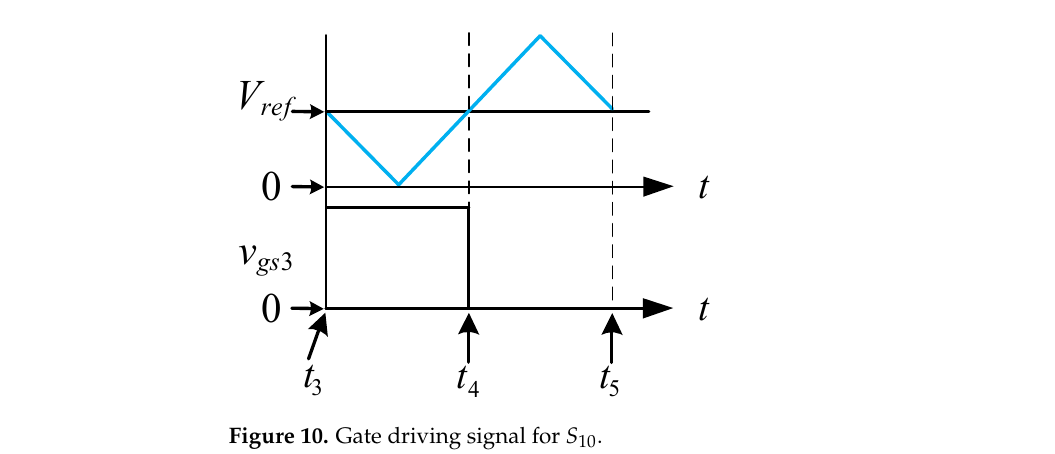
Figure 9. Current flow direction of stage II when switch S 3 is off.